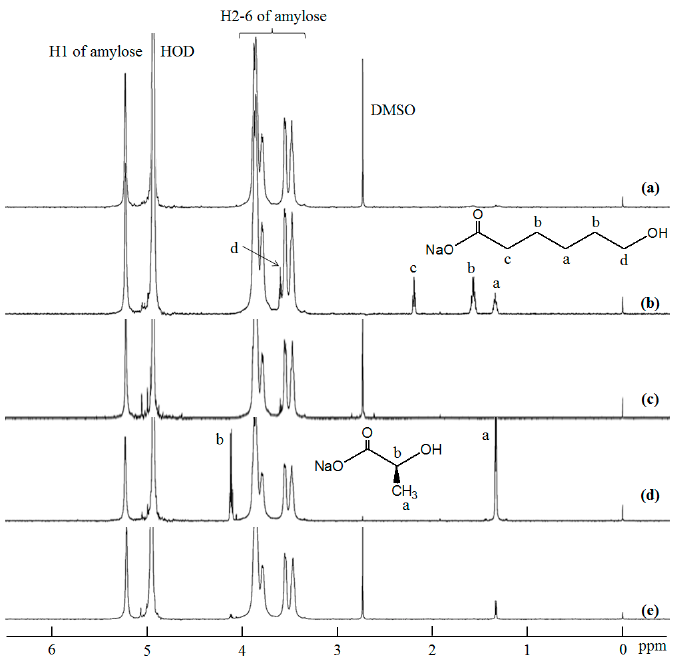
Figure 4. 1 H nuclear magnetic resonance (NMR) spectra of: ( a ) chloroform ‐ insoluble fraction by treatment of amylose–PTHF inclusion complex in DMSO at 25 °C; chloroform ‐ insoluble fractions by treatment of amylose–PCL inclusion complex in DMSO at ( b ) 30 °C and ( c ) 40 °C; and chloroform ‐ insoluble fractions by treatment of amylose–PLLA inclusion complex in DMSO at ( d ) 40 °C and ( e ) 60 °C (0.5 M NaOD/D 2 O).